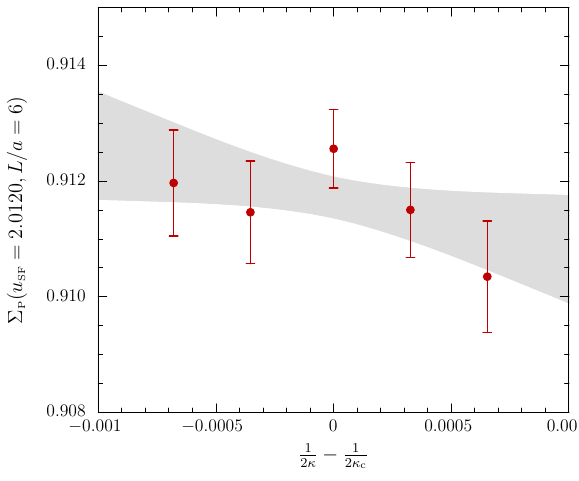
( u = 2 . 0120 , L / a = 6 ) with the P SF